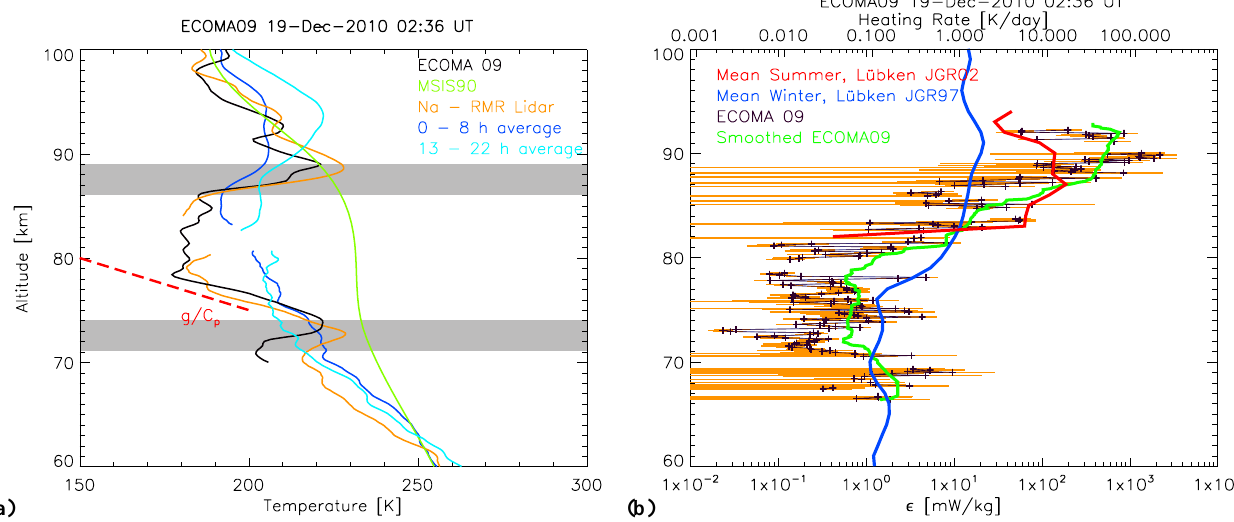
Fig. 1. (a) Neutral temperatures measured during the ECOMA09 flight (black line). Climatologies MSISE-90 is shown as green line. ALO- MAR RMR – Na lidar measurements are plotted with orange line, with a gap between 81 and 84km where no measurements were available. The dashed red line shows adiabatic lapse rate (please see text for details). Altitude ranges where MIL where observed are shaded. (b) Turbu- lence energy dissipation rates (and corresponding heating rates on upper abscissa) measured in situ during ECOMA09 flight (black crosses). Mean summer and winter profiles taken from L¨ubken et al. (2002) and L¨ubken (1997) are shown in red and blue, respectively. The high resolution ε -measurements were smoothed over 5 km to compare to the summer and winter